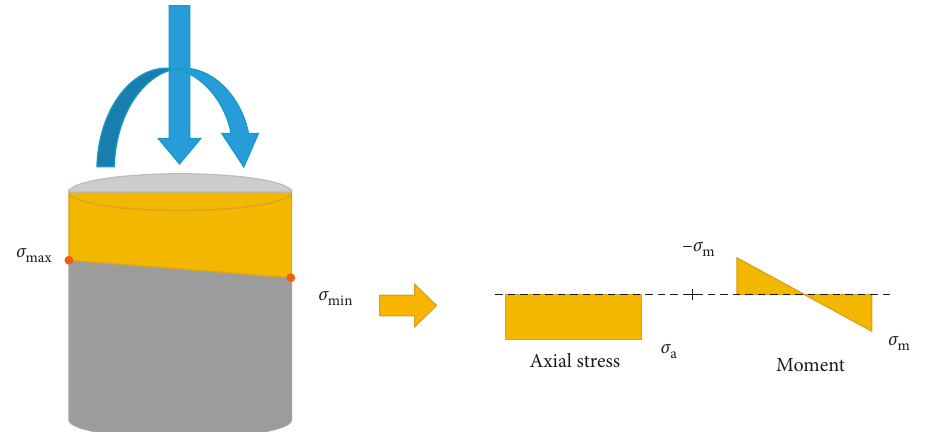
Figure 19: Calculation of the axial force and moment at the pile